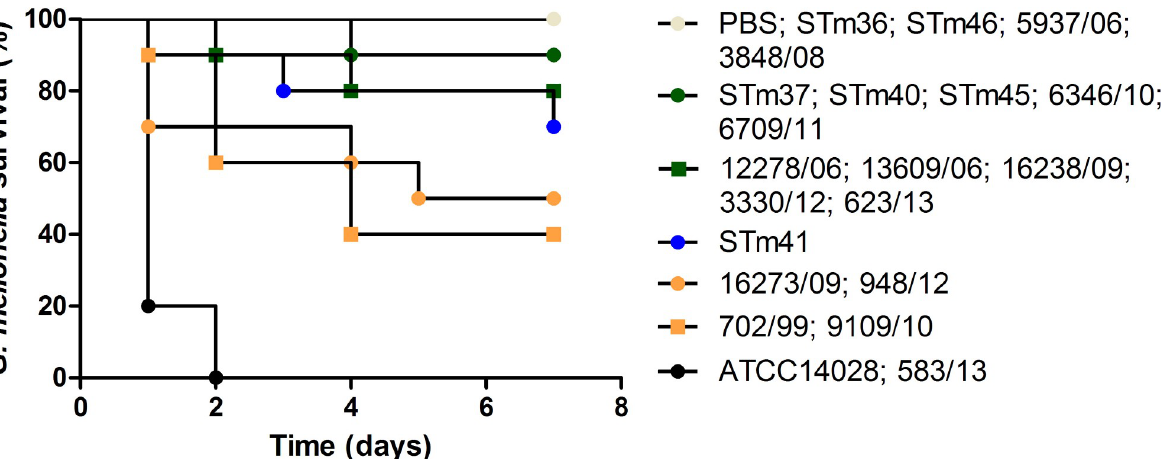
PLOS ONE | https://doi.org/10.1371/journal.pone.0237886 August 18,